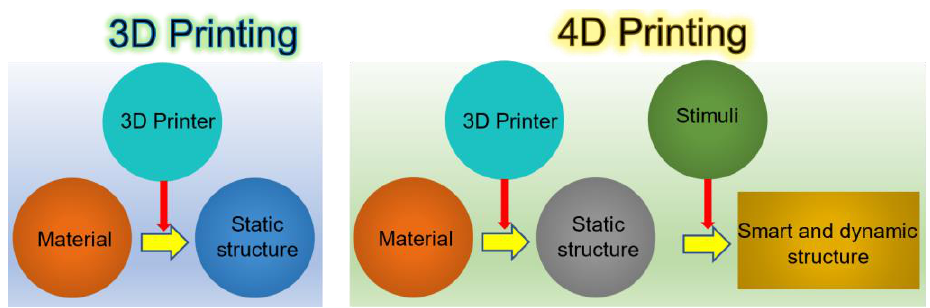
Figure 9. 3D printing and 4D printing and their basic differences, redrawn from [259].